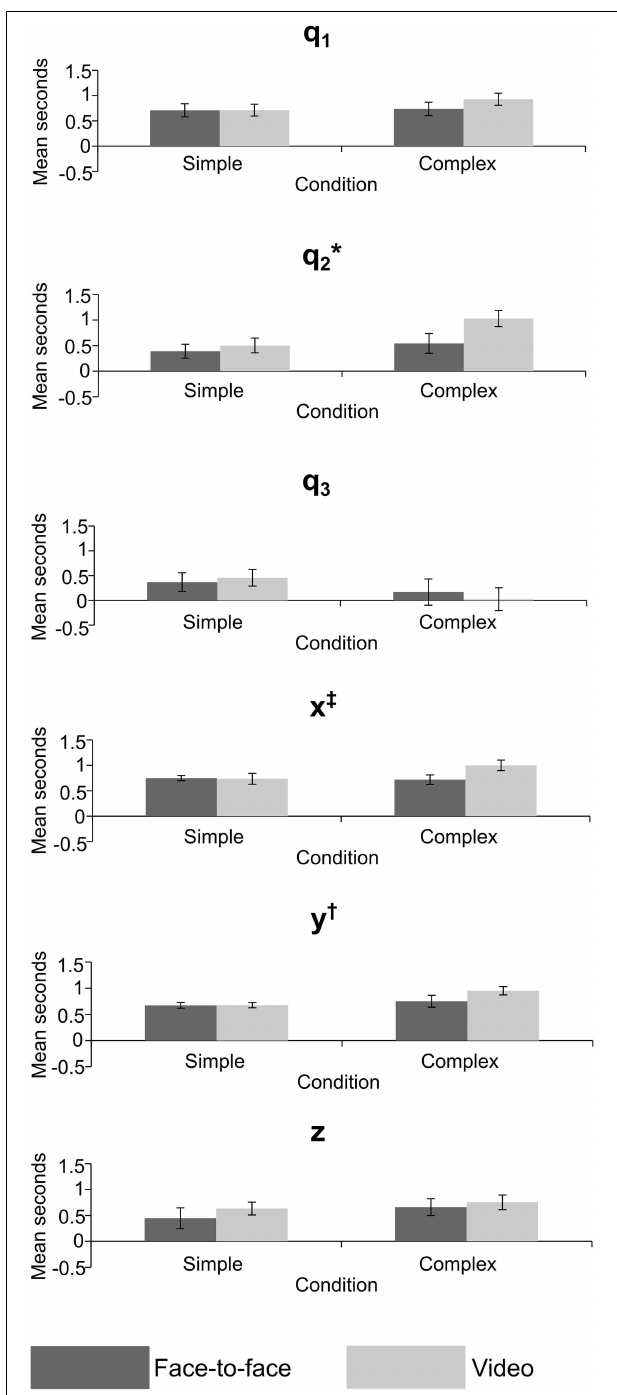
FIGURE 7 | Mean lag in seconds for crossed conditions in the joint angle and grip position variables, error bars = standard error; * significant effect of feedback, † significant effect of task difficulty, ‡ significant interaction. p < 0 . 05 for all significant effects—see Table 2 for exact